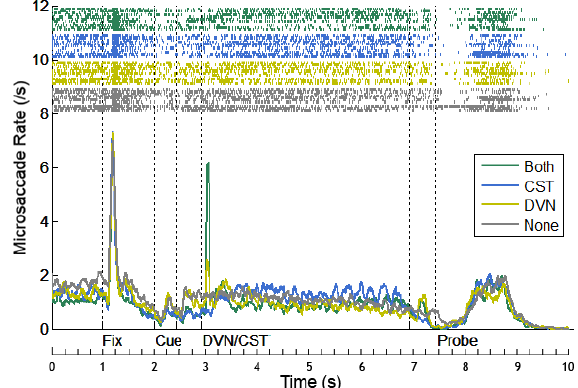
Figure 4. Stimulus onset-locked microsaccade rate functions for all conditions. Raster plots represent microsaccades from seven randomly selected trials from each condition, with each row containing a different participant's